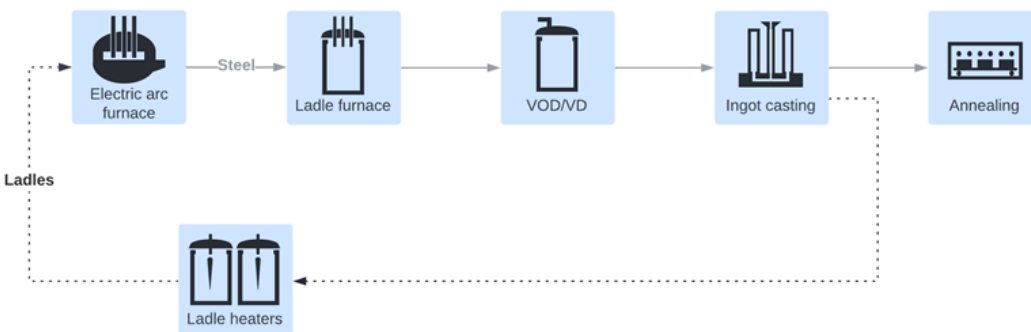
Figure 1. Configuration of the optimization model for the individual scenarios.